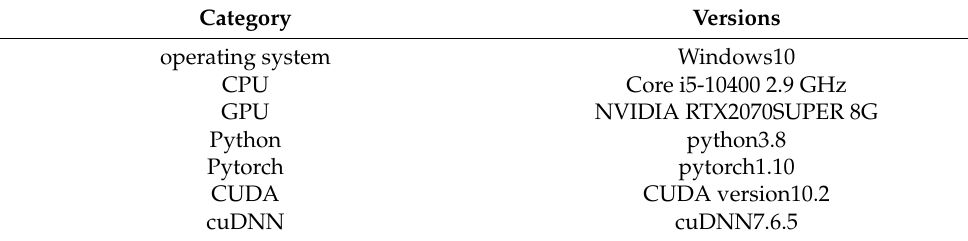
Table 6. Experiment operating